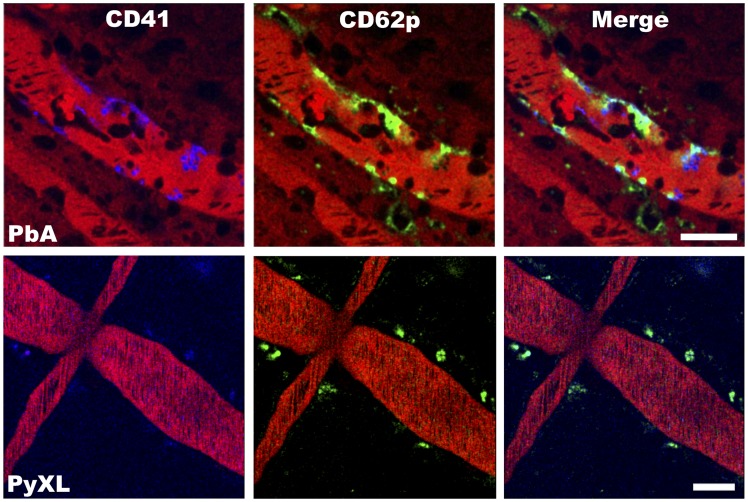
ECM correlates with the arrest of P-selectin expressing platelets in postcapillary venules.PbA-infected mice exhibit small clusters of CD41+ platelets (blue) and patches of P-selectin (green) along the wall of postcapillary venules at the time of ECM. Platelets remained in circulation and P-selectin was not detected in postcapillary venules from PyXL-infected mice with hyperparasitemia. The vascular lumen is visualized with Evans blue (bright red). Note that Evans blue has leaked into the brain parenchyma of the PbA-infected mouse (dark red shade on either side of the postcapillary venule). Scale bars = 50 µm. See Video S20 and 22 for the corresponding dynamic data.